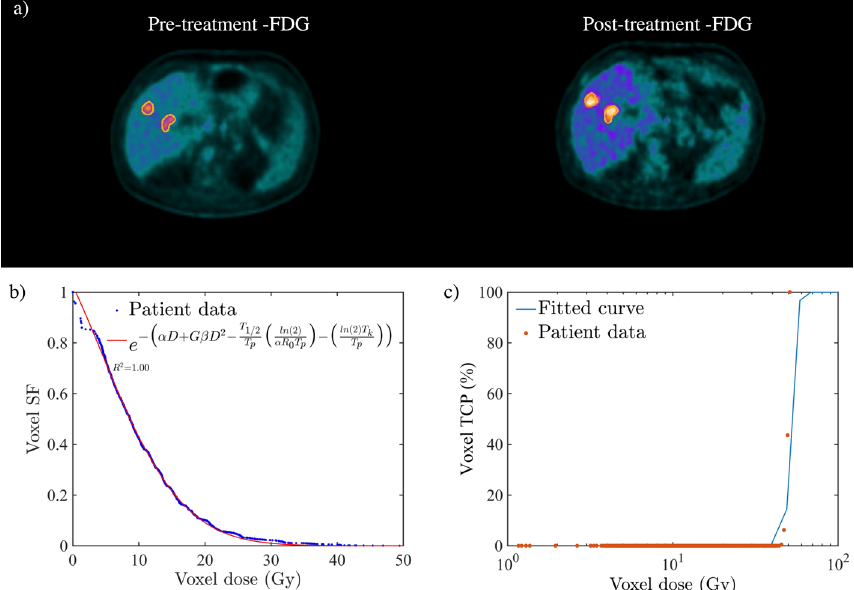
Fig. 2 Progressive metabolic disease (PMD) for a patient with metastatic CRC liver malignancy. Deformable PET images and corresponding calculated voxel SF and TCP. a The deformably registered pre- and post-treatment [ 18 F] FDG PET images. b , c The estimated voxel SF and TCP. The survival fraction and TCP were calculated based on the 90 Y absorbed dose and SUV volume histograms. The radiobiological parameters were derived from the GLQ fit (see Table